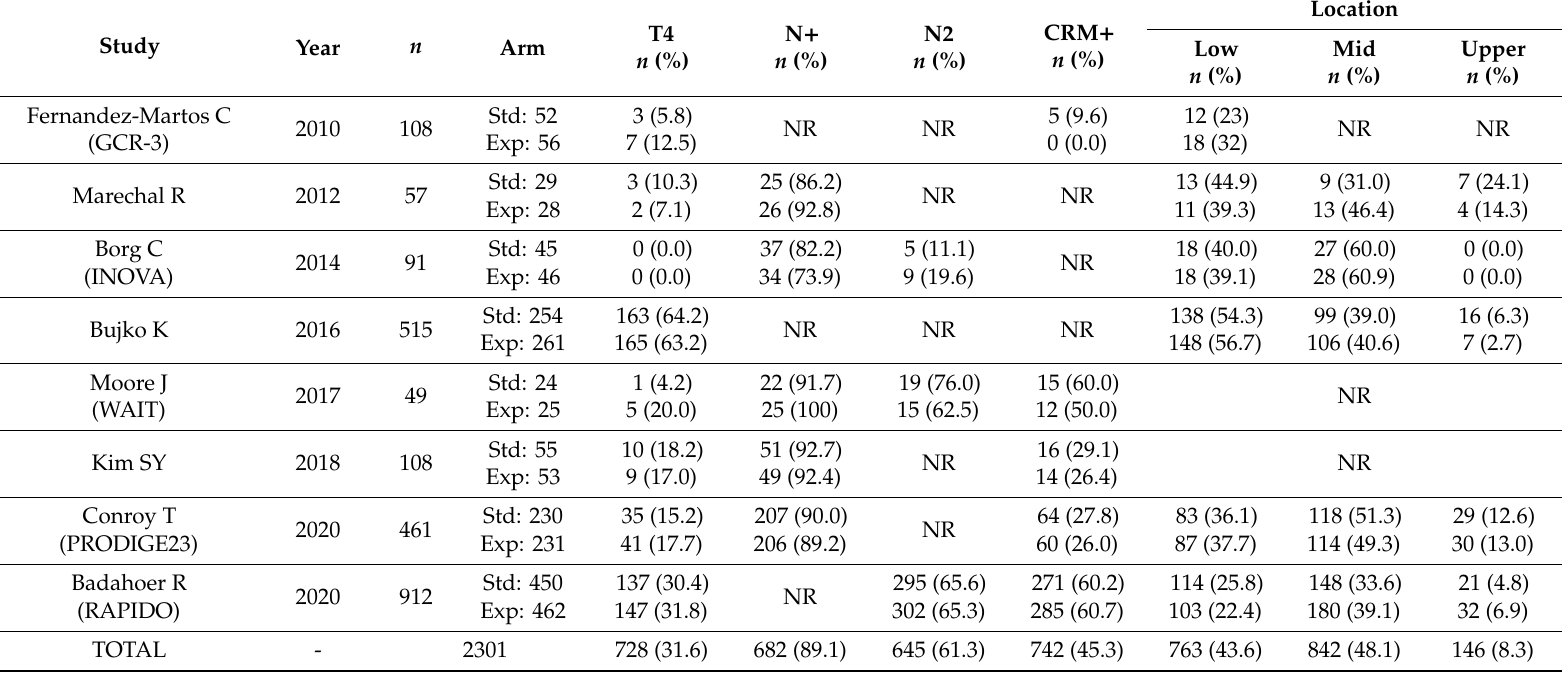
Table 2. Patient characteristics of randomized controlled trials